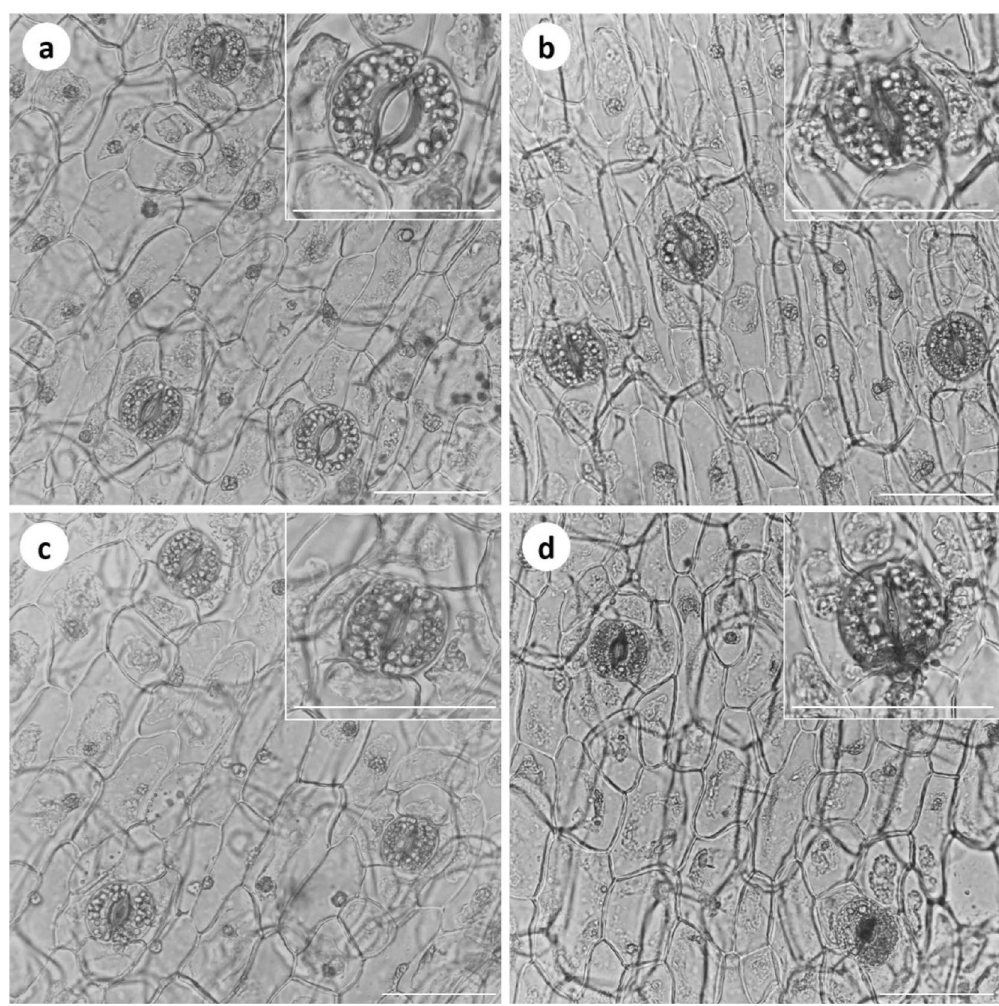
Figure 4. Effect of different PEG 6000 concentrations on the stomatal index and open stomata of Vanilla planifolia . ( a–d ) 0, 1, 2 and 3% PEG 6000, respectively. White bar = 2.5